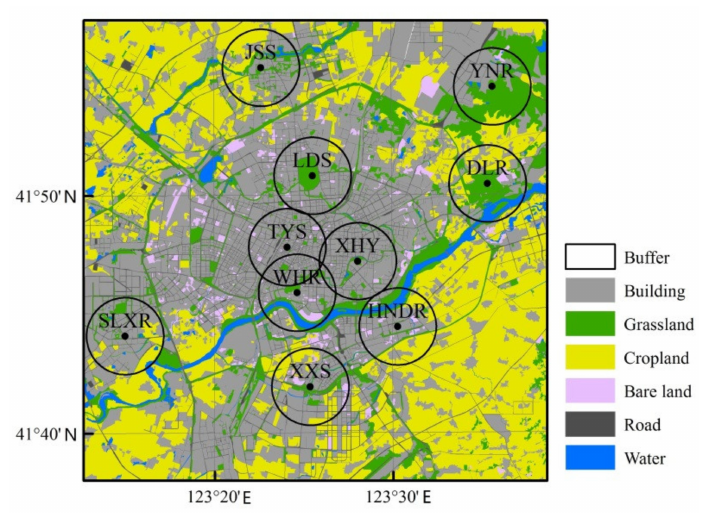
Figure 6. Land-use types surrounding 10 environmental monitoring stations in Shenyang. All bu ff er areas had a radius of 3